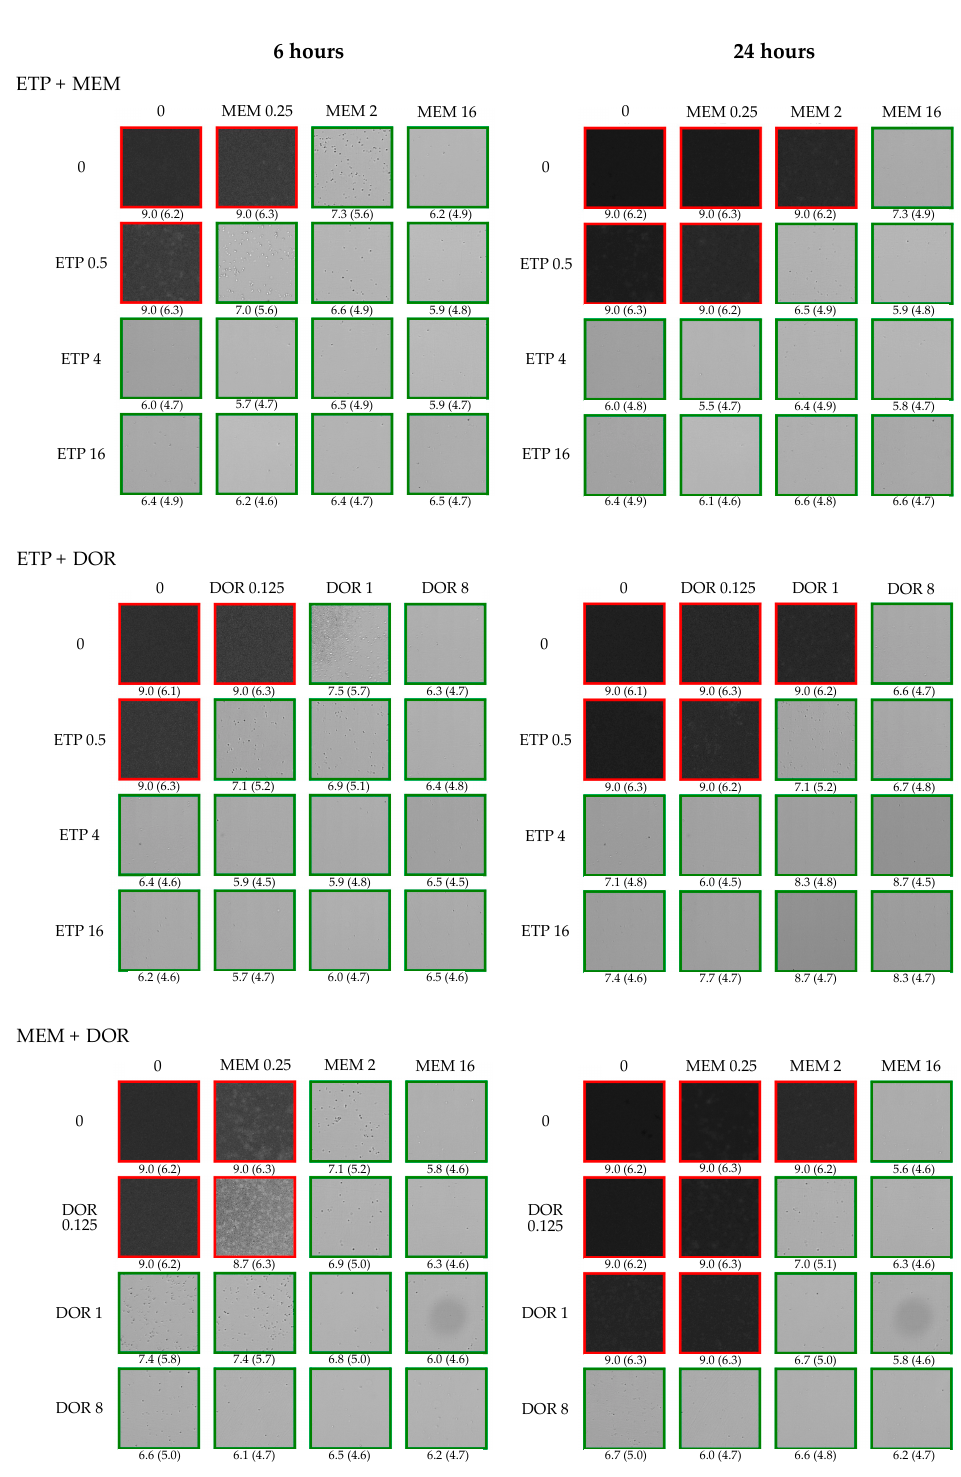
Figure 1. Example of output from time-lapse microscopy experiments. The images were obtained after 6 and 24 h of antibiotic exposure against OXA-48-producing E. coli (ARU891). Antibiotic concentrations are presented in mg/L. The BCA and SESA max (in parentheses) values are presented below each image. If BCA and SESA max exceed the predefined cut-off values (BCA > 8.0 and SESA max > 5.8), indicating a bacterial density of approximately > 10 6 CFU/mL, the image is marked with a red outline. If BCA and/or SESA max are below the cut-off values, the image is marked with a green outline. Abbreviations: ETP — ertapenem; MEM — meropenem; DOR — doripenem.